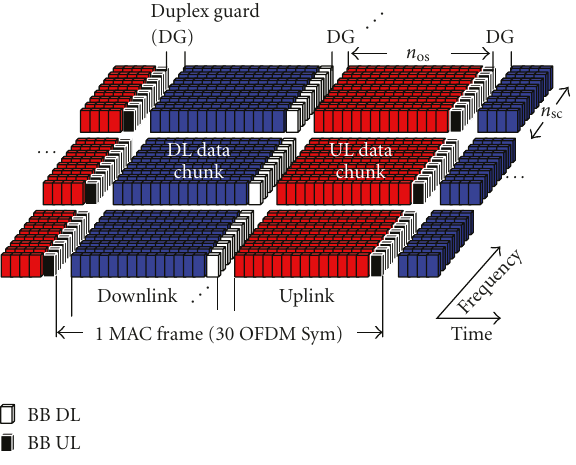
Figure 1: Frame structure for OFDMA-TDD with BB